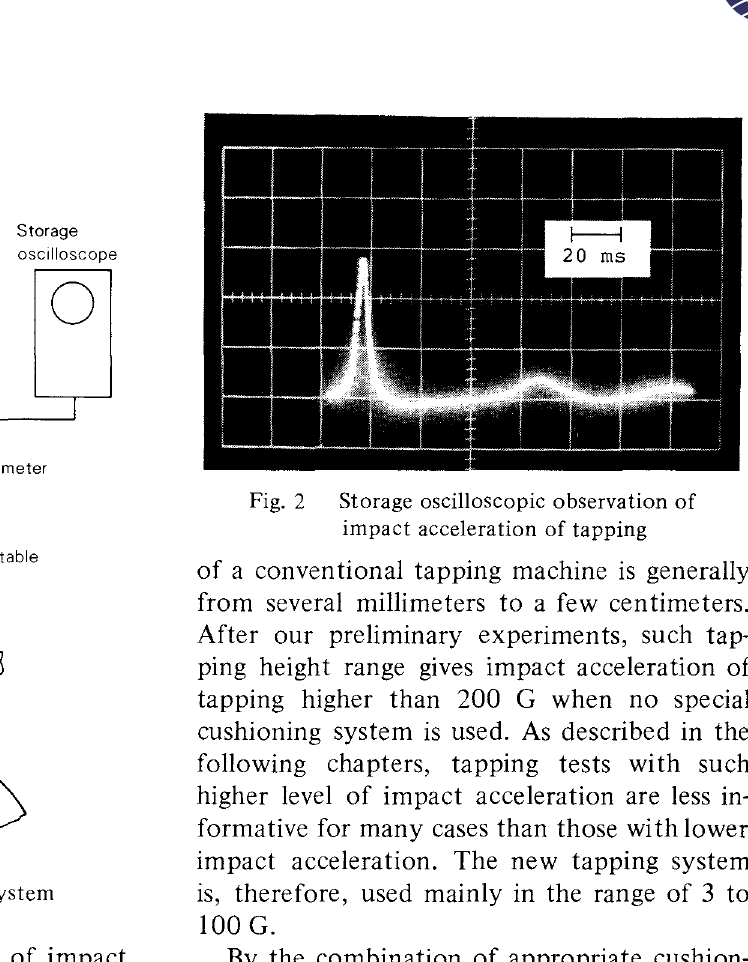
Fig. I Main part of new tapping system